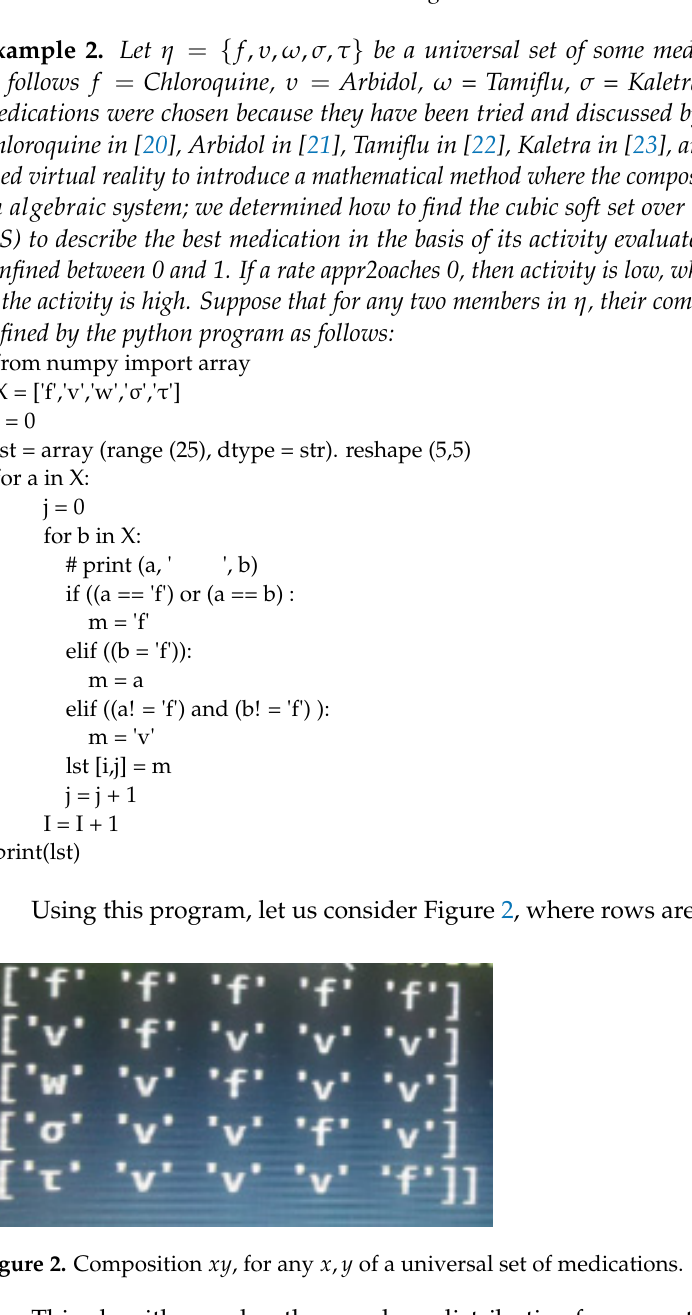
  m 11 · · · m 1 n .   of degree ( n × n ), where   m nn